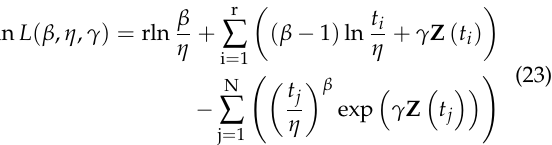
Fig. 1. Proposed art image segmentation